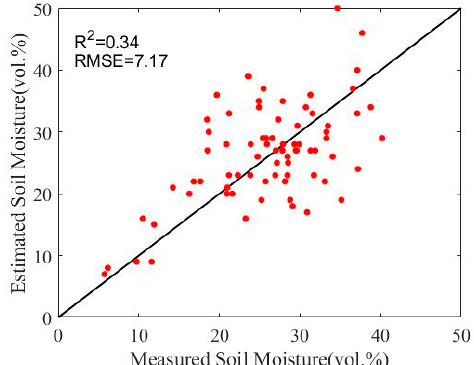
Figure 8. ( a ) Scatterplots between the measured and predicted SMC values on the validation set based on NDVI (Ratio method); ( b ) scatterplots between the measured and predicted SMC values on the validation set based on RVI, the same date as NDVI (Ratio method).